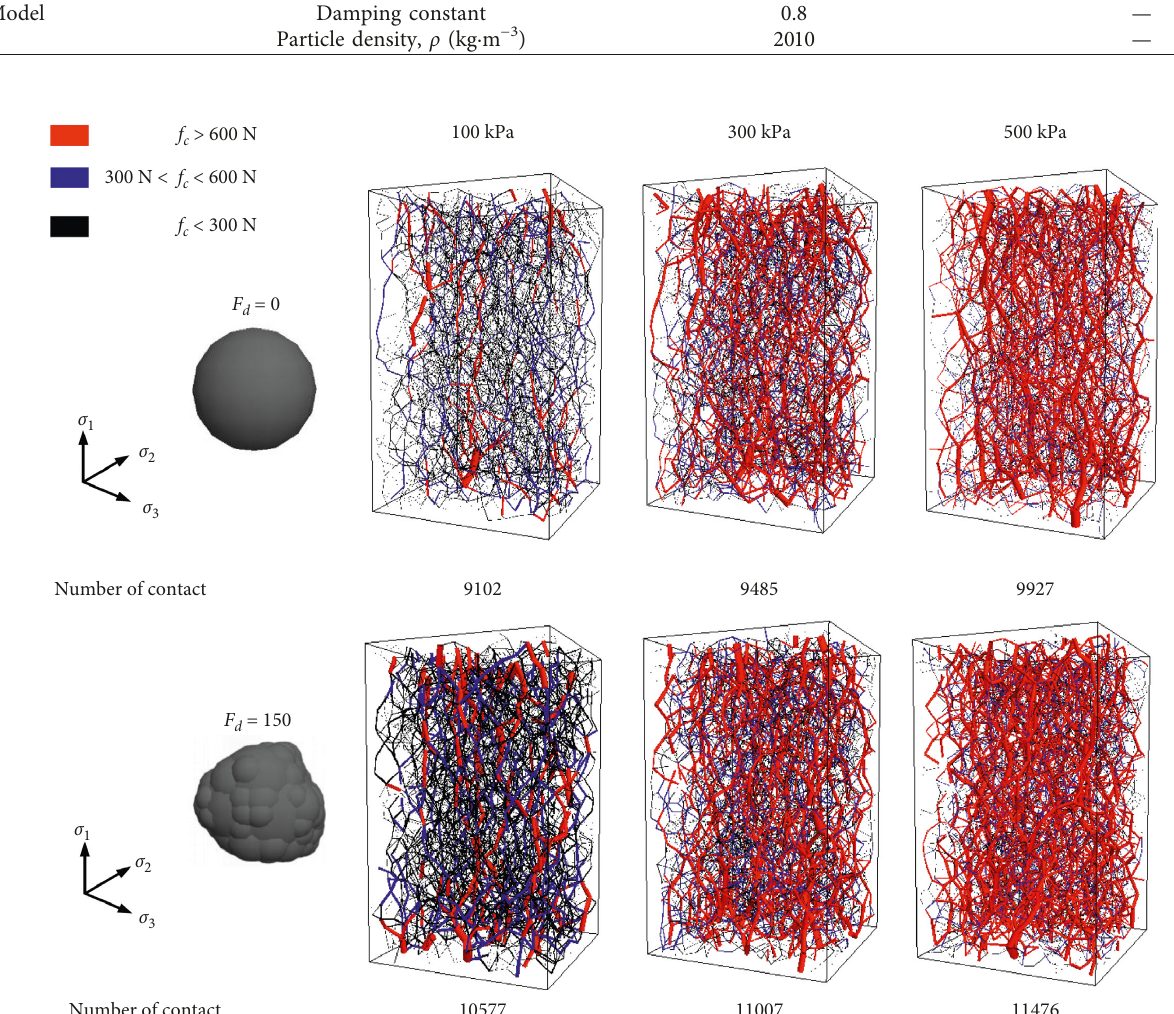
Figure 17: Three-dimensional distribution of the force chain ( ε